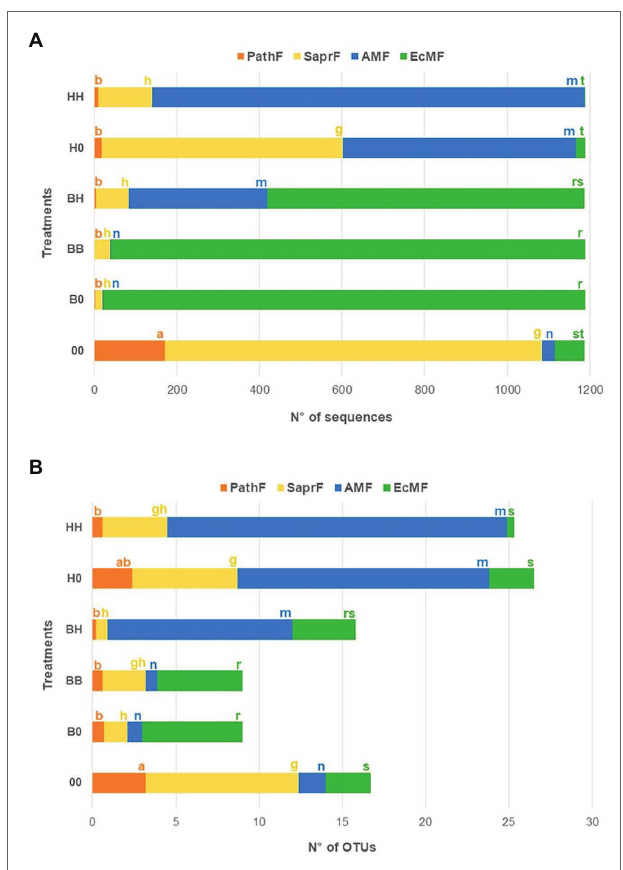
FIGURE 3 | Relative abundance (A) (mean number of sequences) and richness (B) (mean number of operational taxonomic units -OTUs) of each fungal guild in the middle compartments of the experimental treatments. Fungal guilds: EcMF = ectomycorrhizal fungi, AMF = arbuscular mycorrhizal fungi, SaprF = saprotrophic fungi, PathF = pathogenic fungi. For each fungal guild significant differences between treatments ( n = 16) are indicated with different letters (a–b = PathF, g–h = SaprF, m–n = AMF, r–s = EcMF). Treatments: 00 = without plants in lateral compartments, B0 = B. pendula in only one lateral compartment, BB = B. pendula in both lateral compartments, BH = B. pendula and H. caespitosum in lateral compartments (interaction treatment), H0 = H. caespitosum in only one lateral compartment, HH = H. caespitosum in both lateral